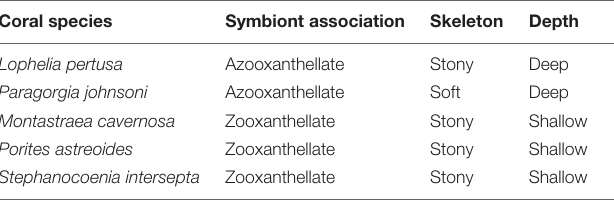
TABLE 1 | Coral species sampled and their associated life-history traits. Coral species